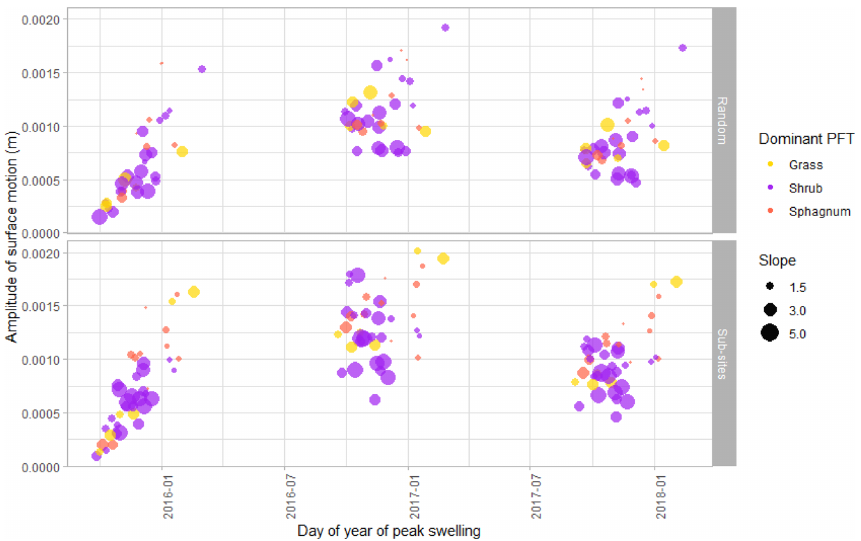
Figure 7. Timing of and relative amplitude for 3 consecutive years (2015–2018) with respect to slope gradient (degrees), dominant plant functional type (PFT; grass, shrub, and Sphagnum ), and polygon type (sub-site and